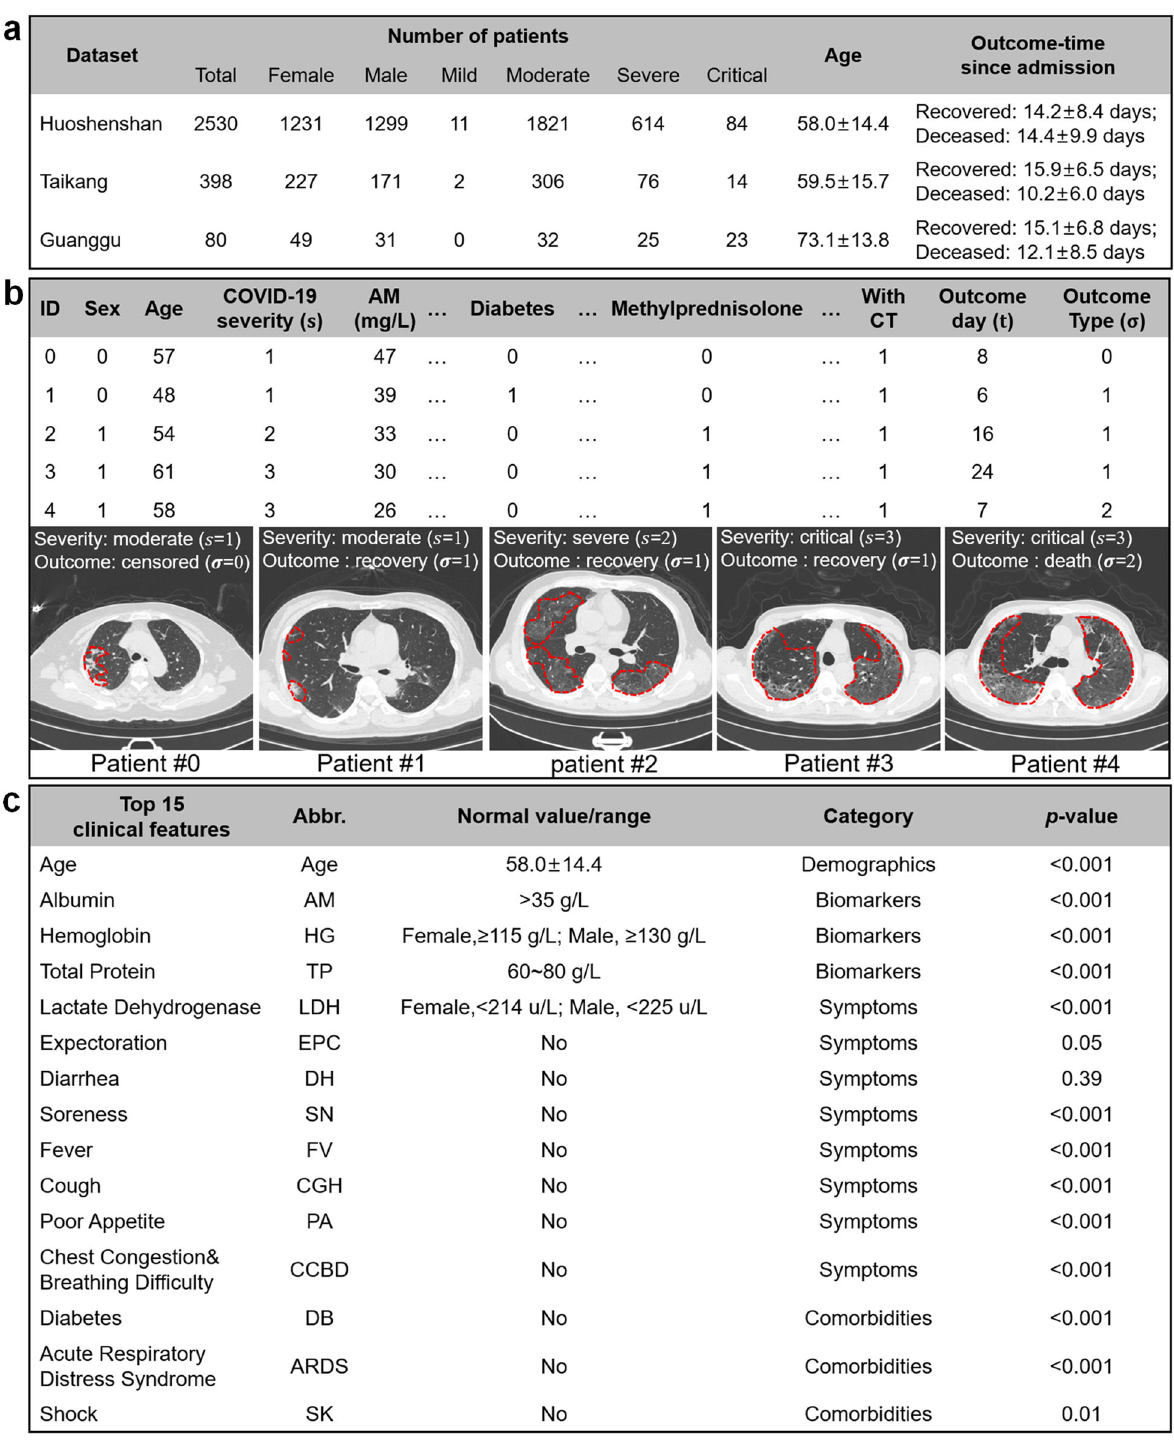
provided in the Methods section.